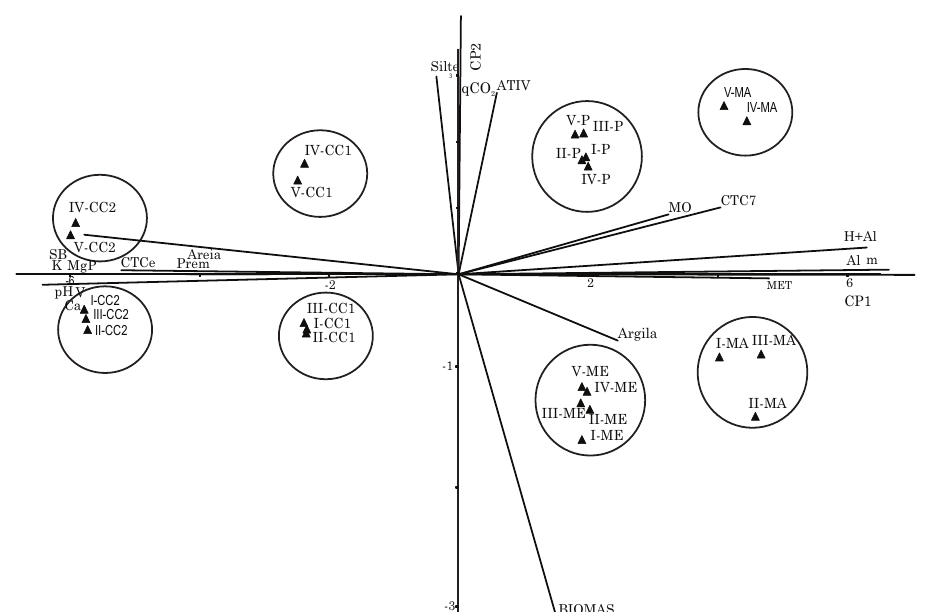
Figura 2. Componentes principais das médias dos atributos químicos e microbianos obtidos nas classes de agregados e tipos de uso da terra. CC1: cultivo convencional com cenoura; CC2: cultivo convencional com abóbora; P: pastagem; MA: mata com araucária; e ME: mata de eucalipto. Classes de agregados: I: 4,00-2,36 mm; II: 2,36-1,18 mm; III: 1,18-0,60 mm; IV: 0,60-0,30 mm; e V: 0,30-0,15 mm. Atributos físicos: teores de argila, silte e areia. Atributos químicos: pH, MO (matéria orgânica), SB (soma de bases), V (saturação por bases), m (saturação por Al 3+ ), CTCe (CTC efetiva), CTC7 (CTC a pH 7) e teores de Al, P, Ca, K, Mg, P, Prem (P remanescente). Atributos microbianos: BIOMAS (carbono microbiano), ATIV (atividade microbiana) e qCO 2 (quociente